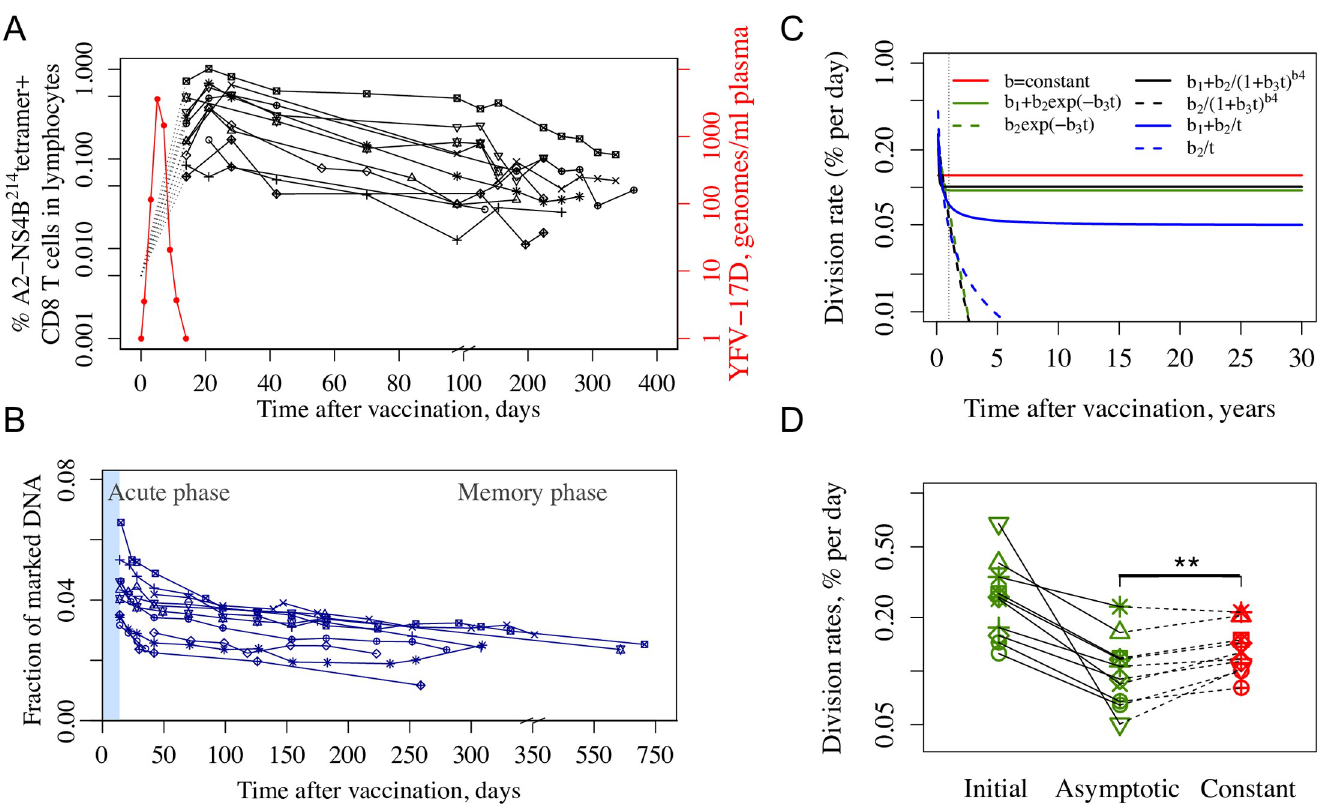
Fig 1. Dynamics and turnover of YFV-specific CD8 T cells in the first year after YFV-17D vaccination in the Akondy study. Panel A shows the dynamics of the virus (red) and YFV-specific CD8 T cell numbers (black) in the blood. Panel B shows the deuterium incorporation and die-away of label enrichment in YFV-specific CD8 T cells in individuals given D 2 O in their drinking water from day 0 to 14 post immunization (blue shaded region). Data in Panels A,B are from [24]. Panel C shows the estimated division rate over 30 years for all models tested (different functions describing the change of division rate over time are shown and color-coded as red, black, green and blue, see also fits to individual donors in S1 Fig). Panel D shows the division rate estimates with green symbols corresponding to initial and asymptotic division rates for the best model ( b ( t ) = b 1 + b 2 exp ( − b 3 t )). The red symbols correspond to the division rates estimated from the constant division rate model. Each individual is shown by a different symbol. Solid and dotted lines connect the data for each individual obtained from the two models.